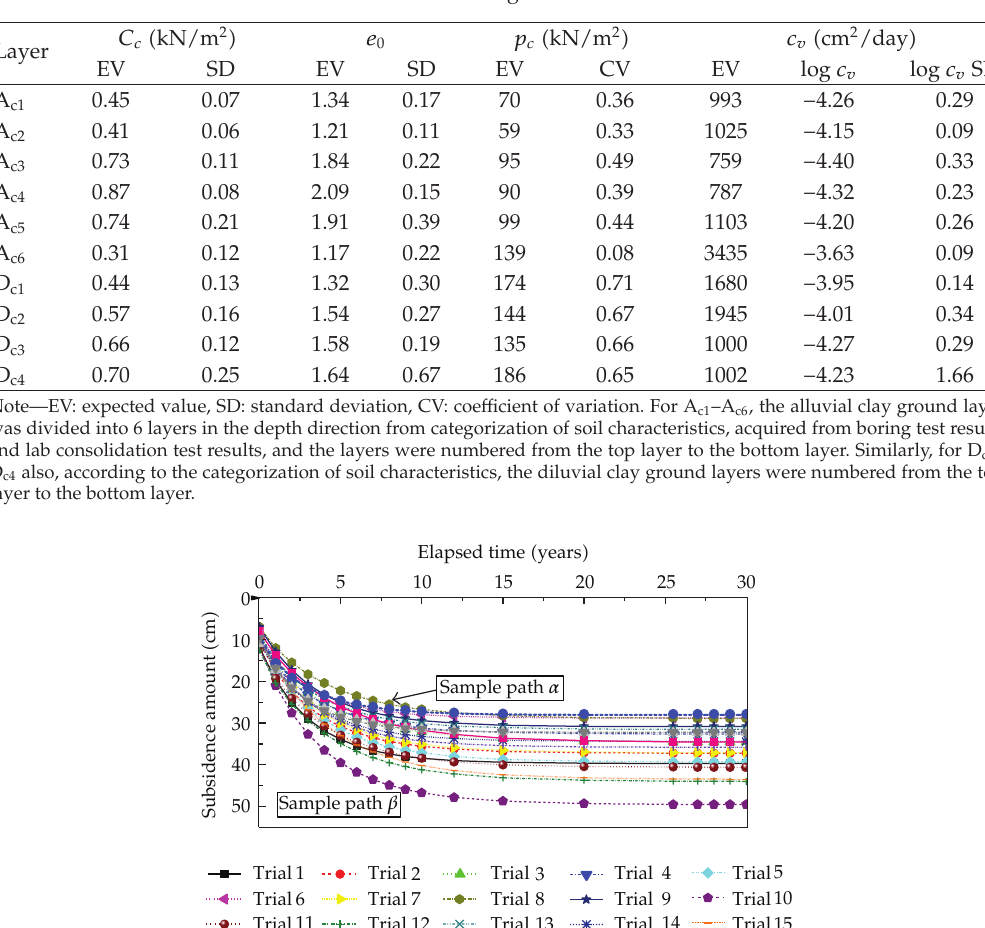
Table 2: Soil constants for inhomogeneous subsidence simulation.